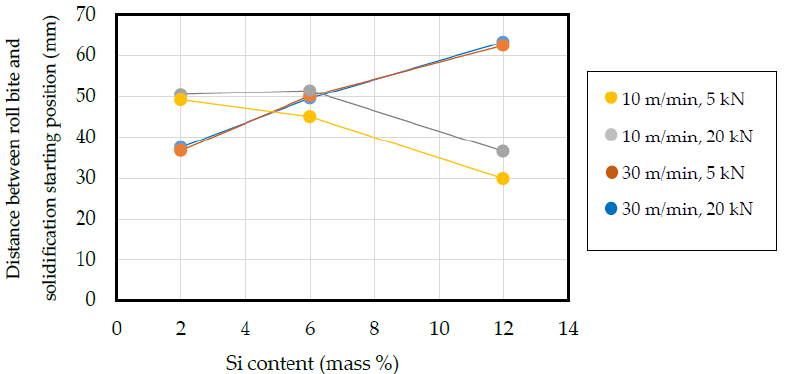
Figure 7. Effects of roll speed, roll load, and Si content on solidification starting position of Al-Si. Roll speed: 10 m/min and 30 m/min; roll load: 5 kN and 20 kN; Si content: 2%, 6%, and 12%.